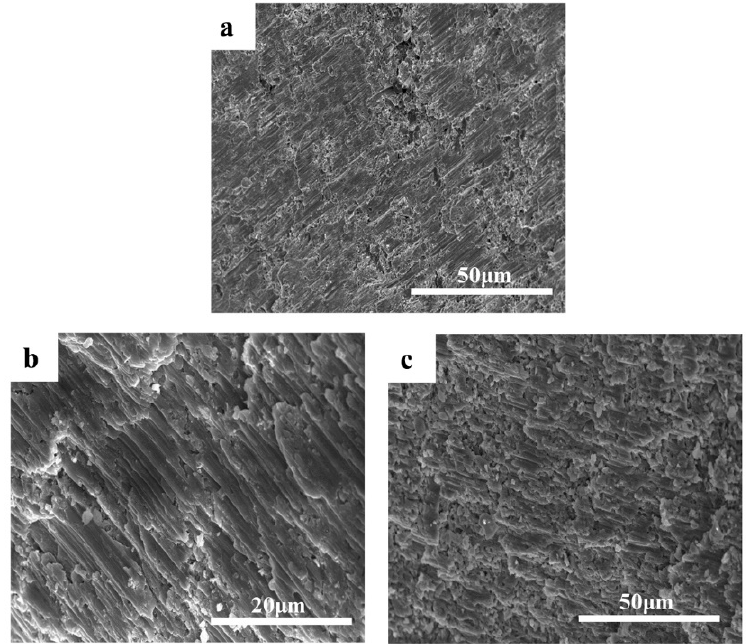
Figure 8. Fracture morphology of Al 2 O 3 /Al-20Si composites under different pressures ( a ) 0.02 GPa; ( b ) 3 GPa; ( c ) 4 GPa. ( b ) 3 GPa; ( c ) 4